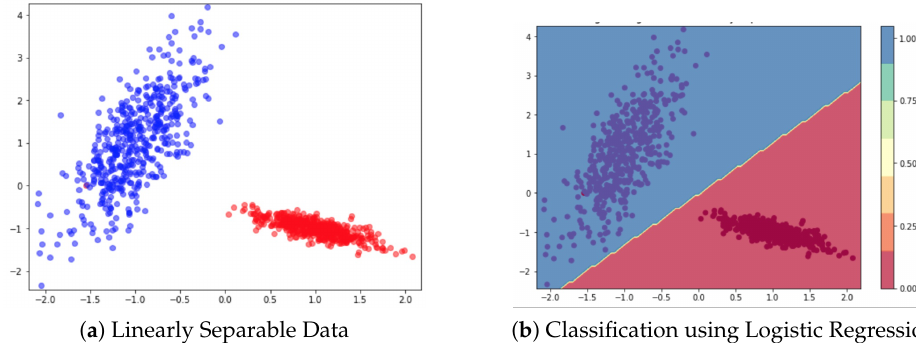
Figure 5. Classification of linear data using the Logistic Regression model.